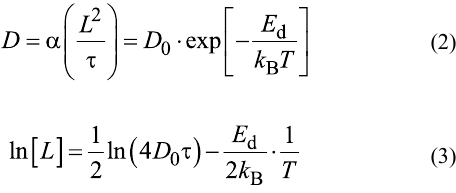
at elevated temperatures during the annealing process. There- fore, the STM measurements represent a snapshot of the diffu- sion process that took place at the last annealing